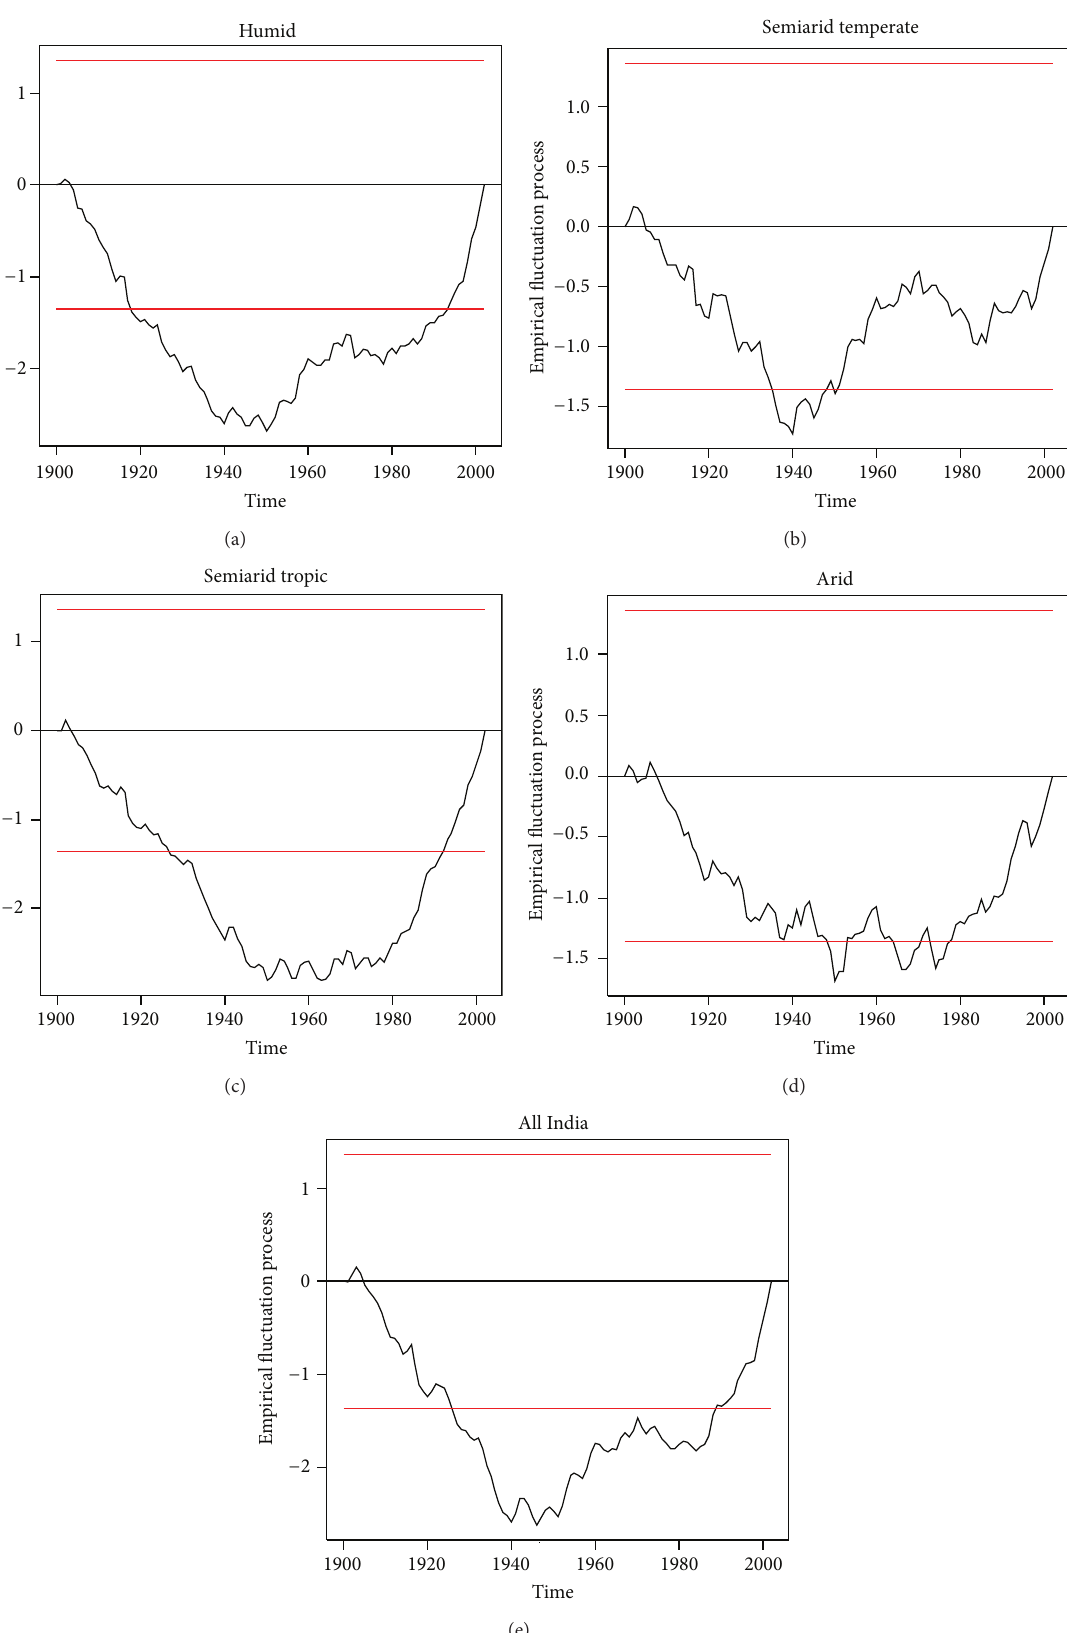
Figure 1: Structural break in annual average